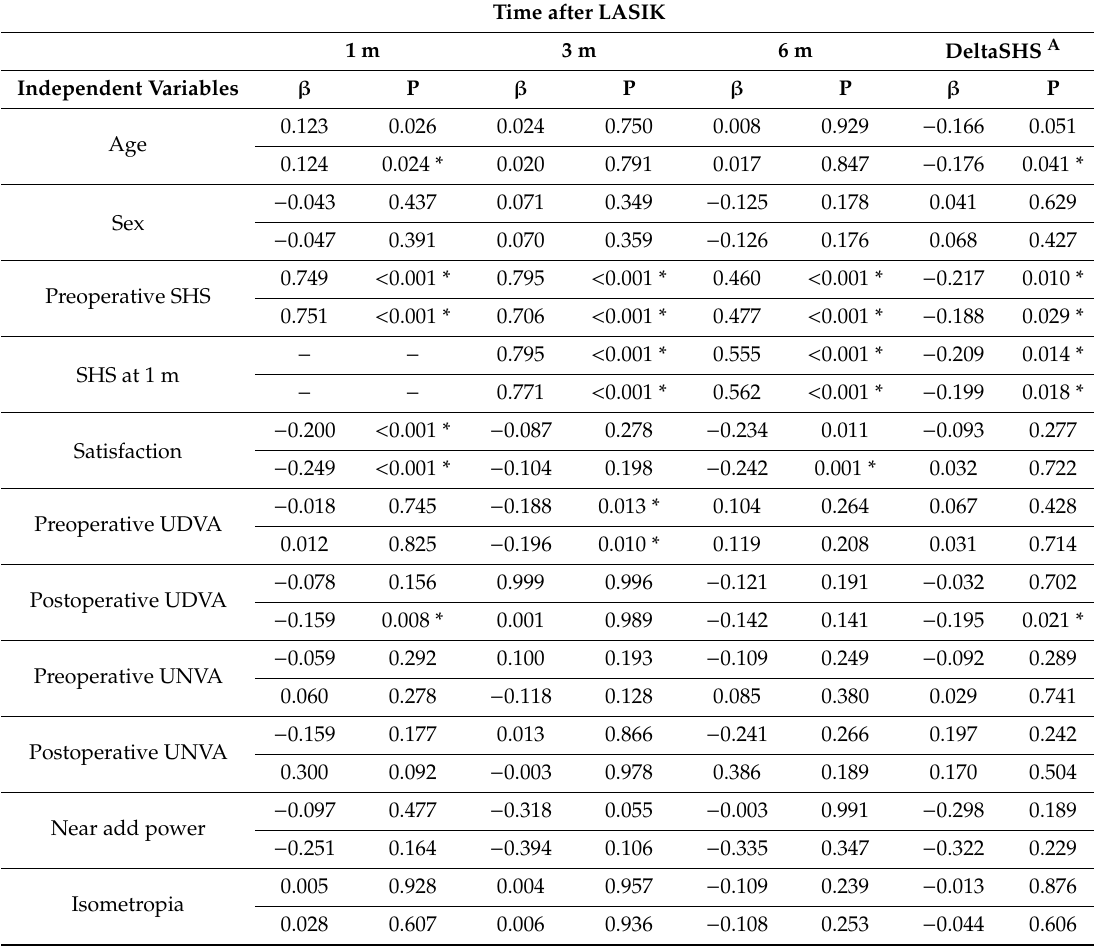
Table 2. The results of linear and multiple regression analyses on factors associated with postoperative subjective happiness (SHS).